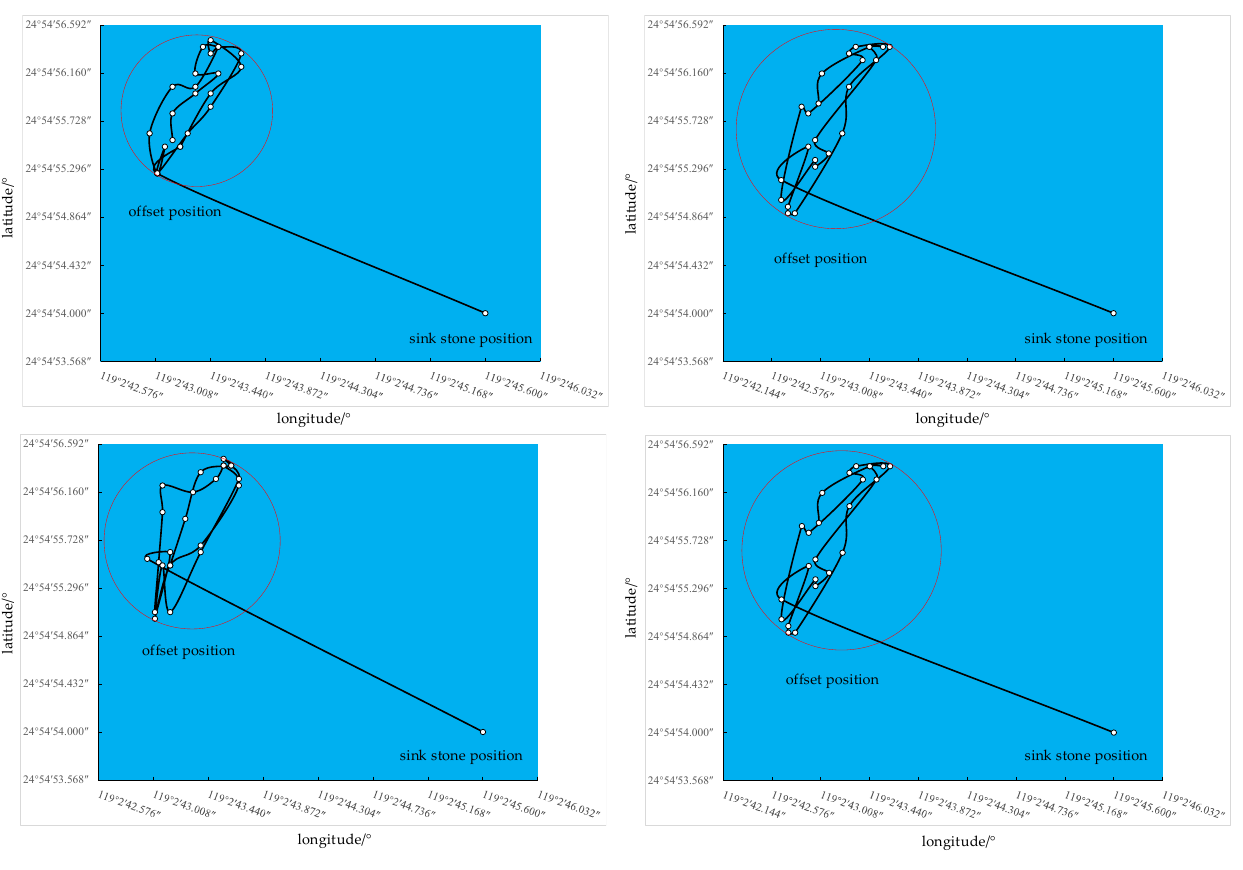
Figure 2. Field of buoy offset.